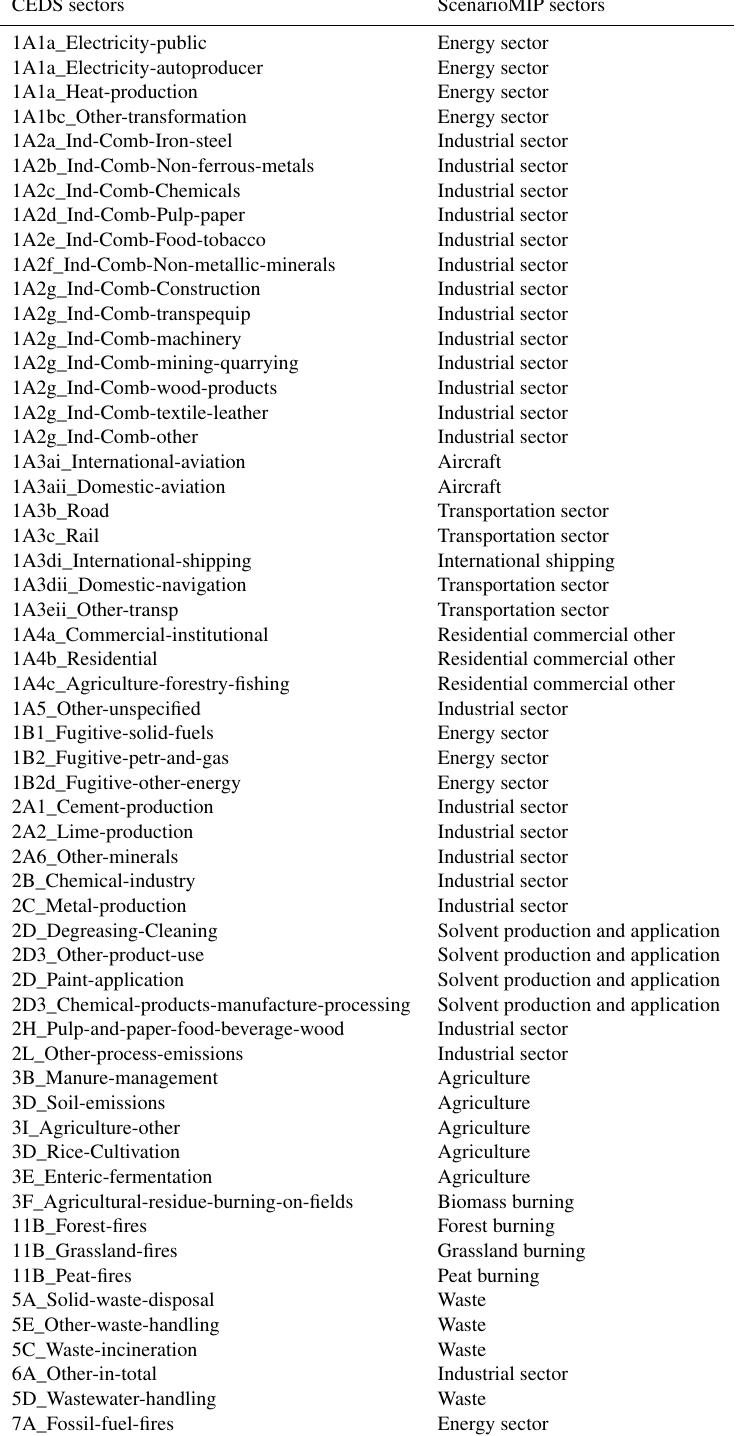
Table B1. The sectoral mapping used to aggregate historical data to a common sectoral